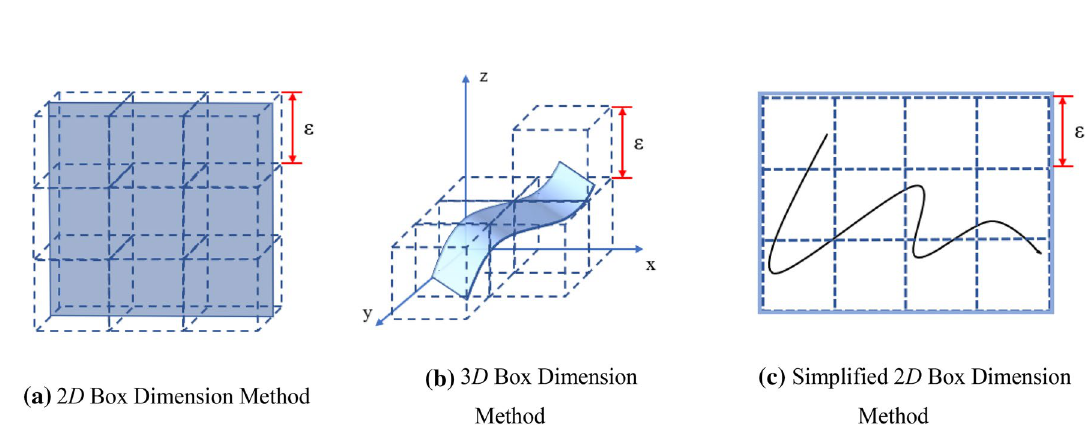
Figure 4. Schematic diagram of box dimension